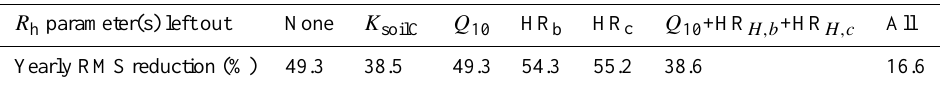
Fig. 4. Optimized values of the parameters. Table 3. All-site yearly reduction of the model-data NEE RMS from the prior model, for various combinations of R h parameters left out the